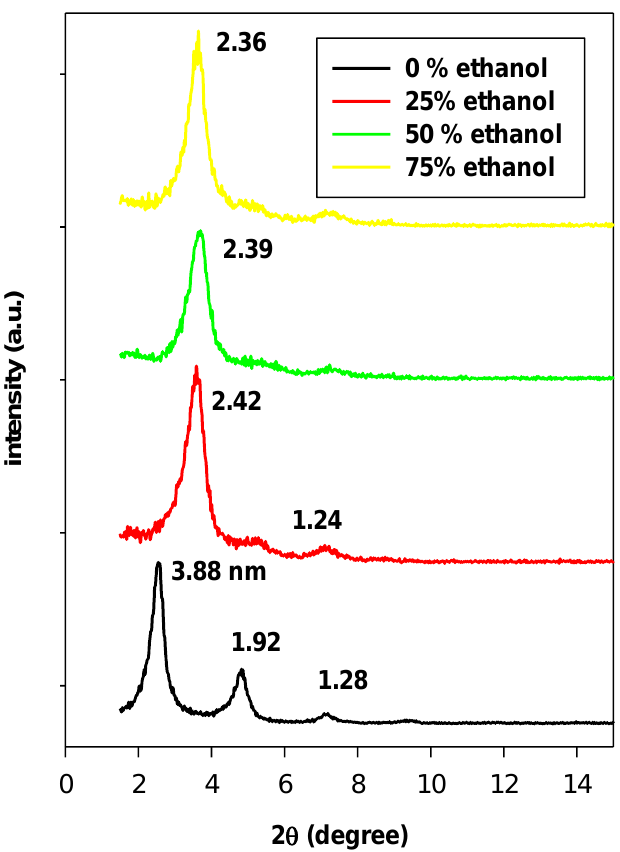
Figure 5. PXRD patterns of C16BrPG-2.40 washed with different aqueous ethanolic solutions (volume%).